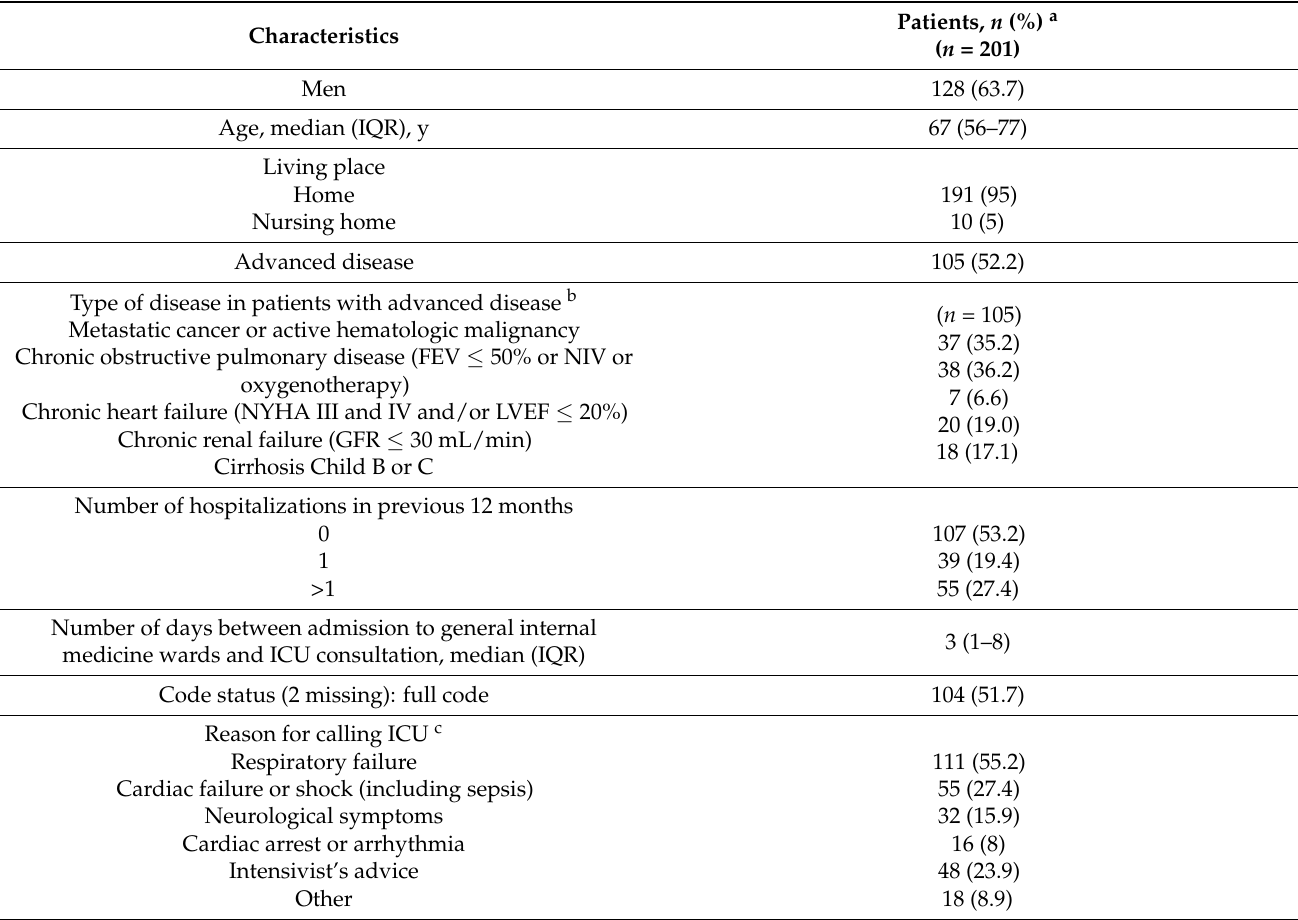
Table A1. Patients’